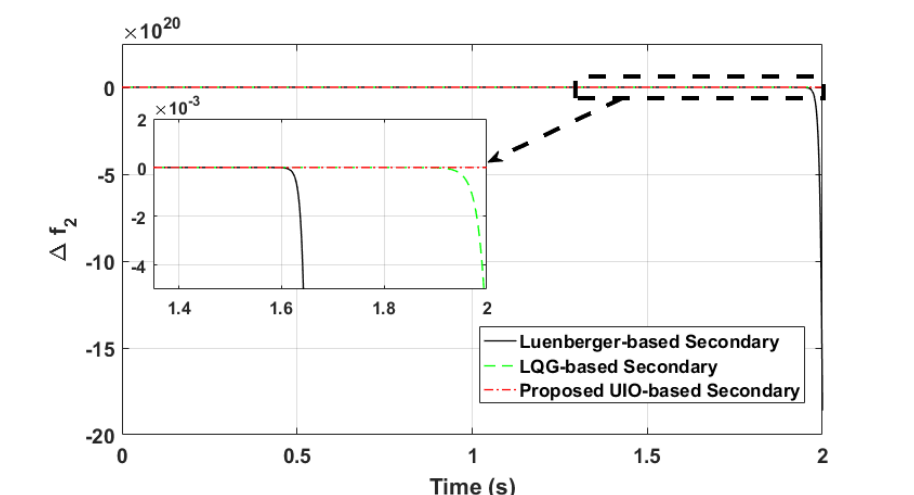
Figure 16. Second inverter frequency dynamic ∆ f 2 in scenario 3 (Stealthy FDI to second inverter’s ac- tuator).